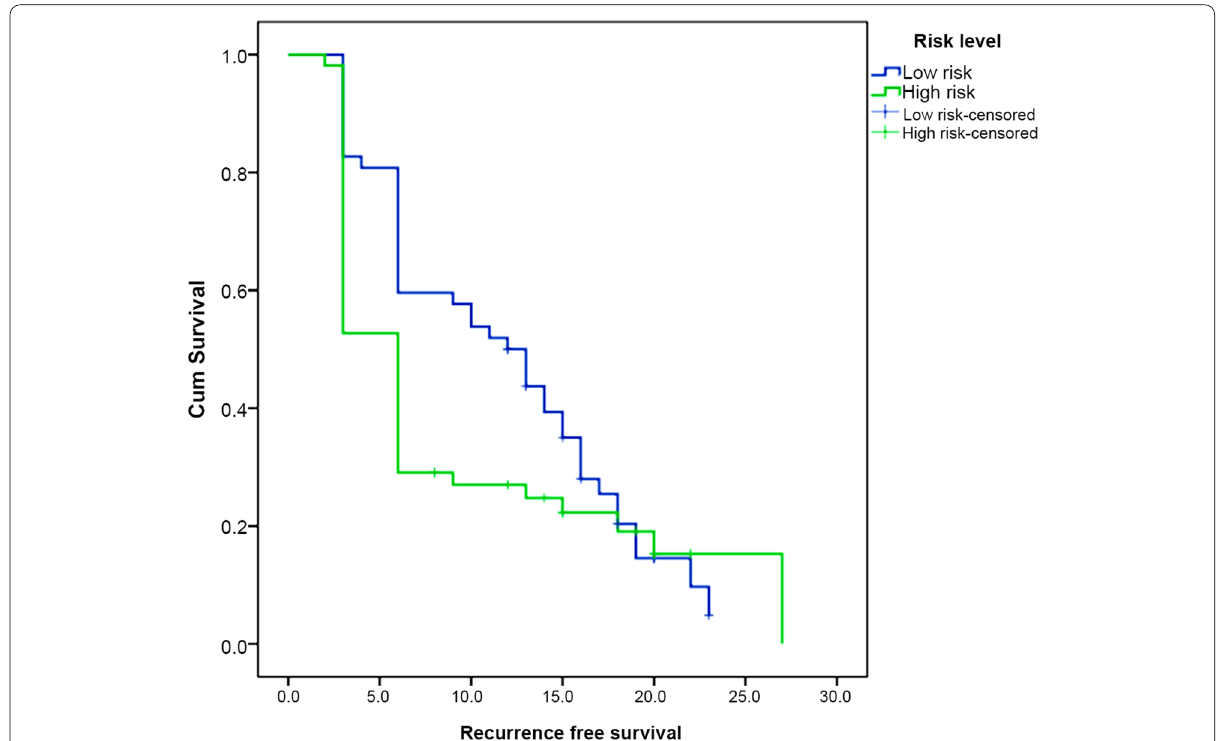
Fig. 2 Kaplan–Meier curve comparing recurrence-free survival in low- and high-risk